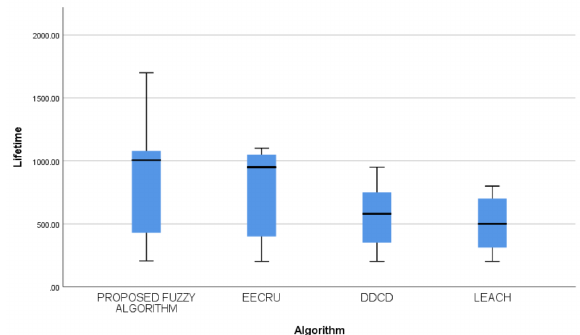
Figure 4. Boxplot representing the performance of algorithms.